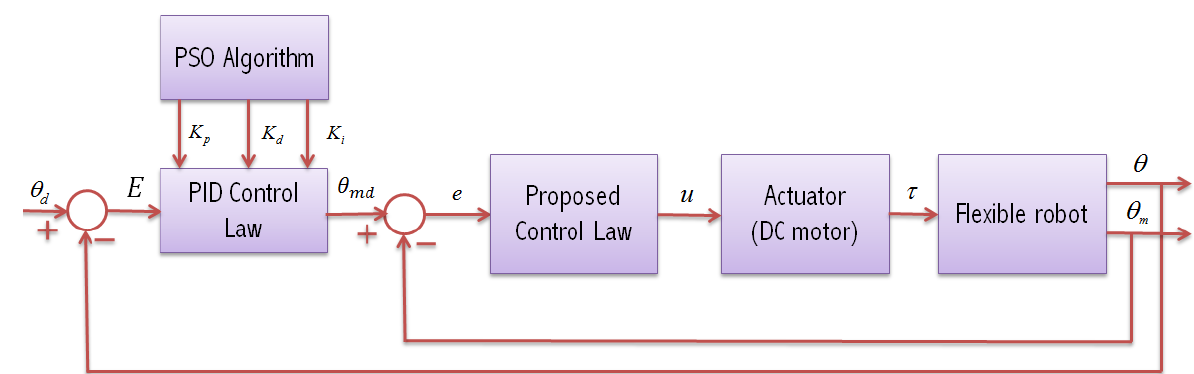
Figure 1. Block diagram of control